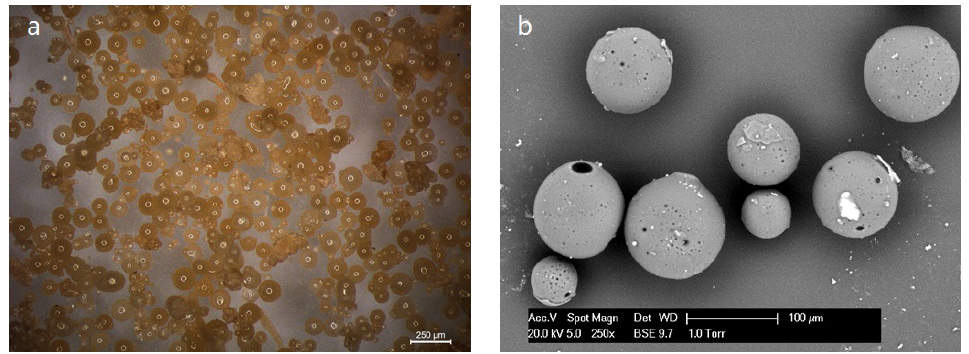
Figure 4. Images of PF microcapsules obtained by ( a ) OM; and ( b ) ESEM.